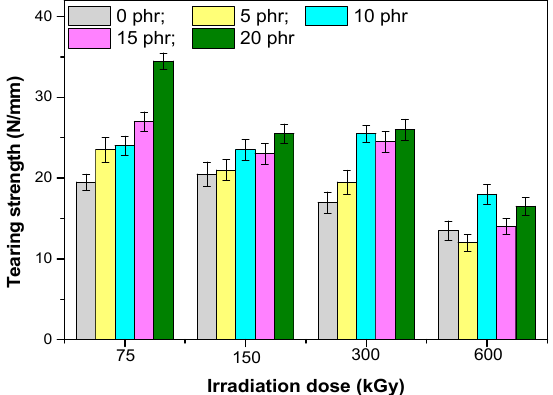
Figure 2. Tearing strength versus electron beam irradiation dose and the amount of hemp fibers.